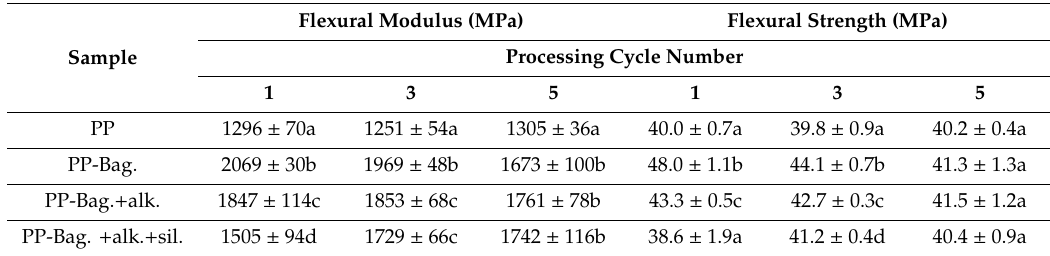
Table 2. Flexural properties of PP and PP-Bagasse